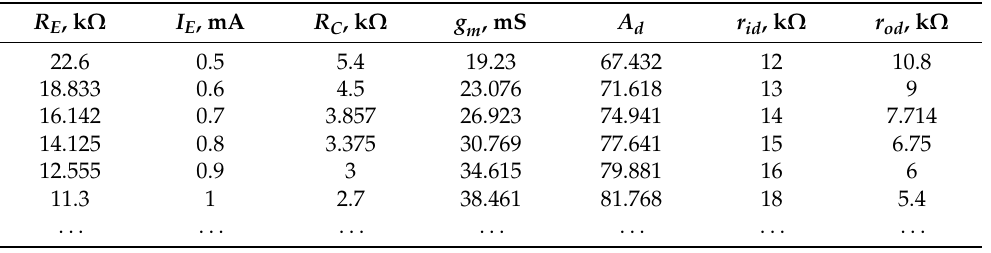
Table 5. Parameters of differential pair.